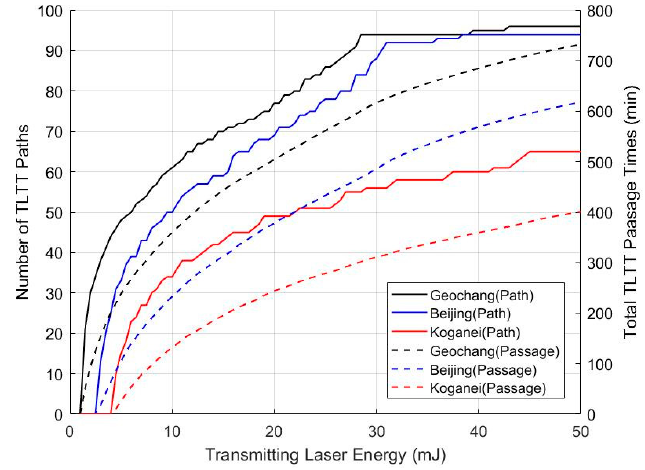
Figure 7. Number of TLTT paths and total TLTT passage times to enable TLTT link in terms of transmitting laser energy. Table 3. Number of TLTT paths and total TLTT passage times with respect to transmitting laser energy. Laser